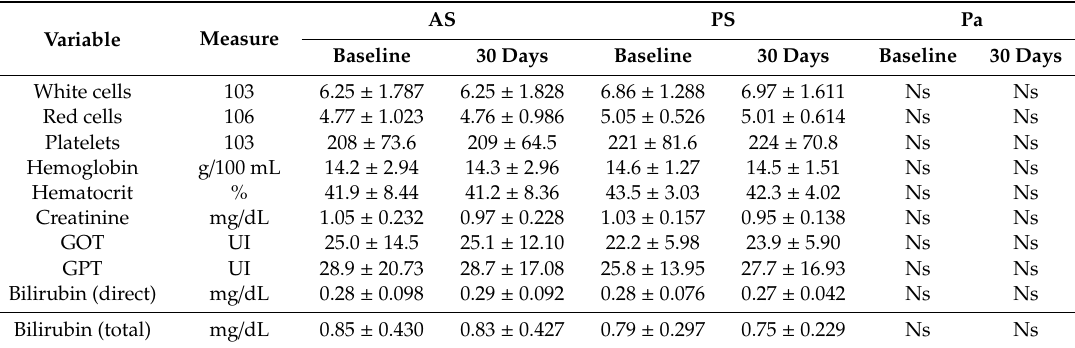
Table 4. Laboratory analysis: mean ± SD at baseline and after 30